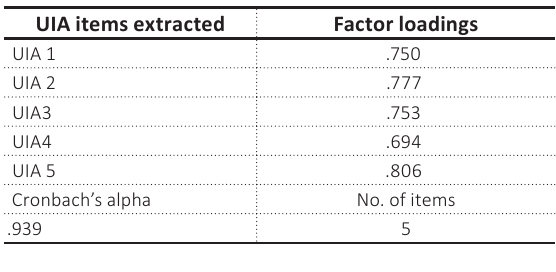
Table 5. Factor: Performance Monitor